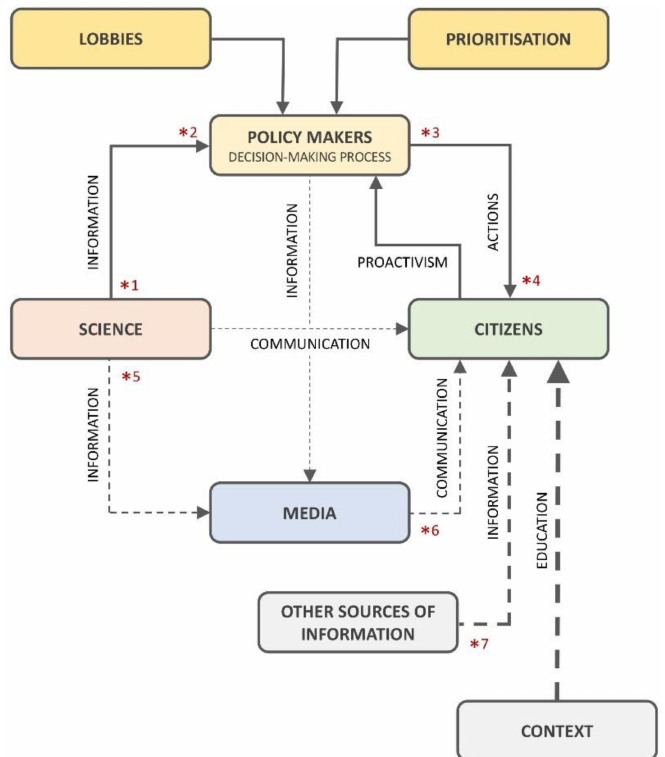
Figure 1. Model of information flow and communication of HBM knowledge (communication from media and science, information from other sources, and education from the context, all together seems to affect, at different levels, citizen perceptions on the health impact of chemical exposure. The asterisks indicate critical points related to the way information is emitted or received by the stakeholders. Continuous lines represent that information or actions flows in closed circuits, i.e., not taken into consideration citizens perceptions or needs. Dotted lines indicate an open flow of information to which citizens are exposed to. The thickness of these lines is related to the level of influence on citizens’ perceptions and attitudes. Therefore, the context (subjectively understood here as the combination of individual, social, and place attributes) seems to have more influence than other sources of information (e.g., social media), media, and science communication) (empirical data driven model: citizen